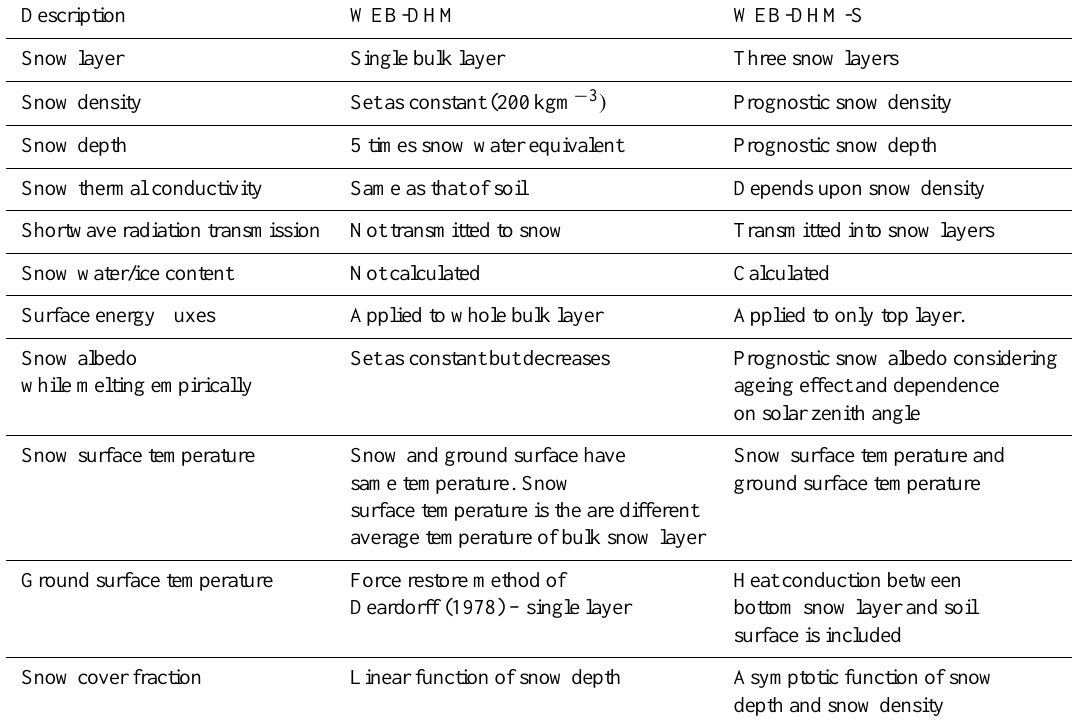
Table 1. Major differences of snow processes in WEB-DHM and